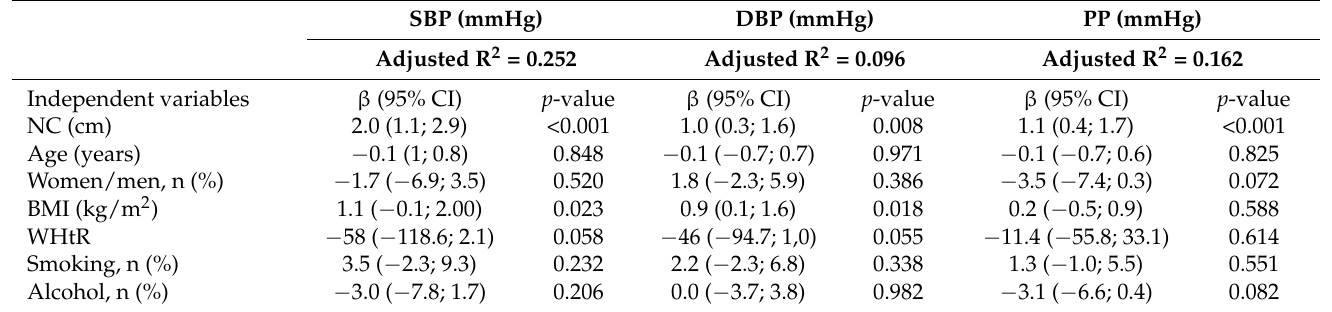
Table 3. Independent associations between the BP as the dependent variable and the NC as the main independent